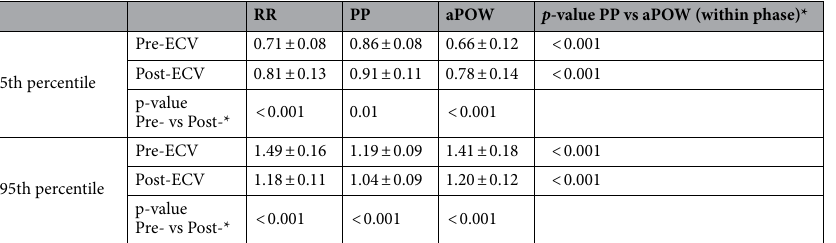
Table 3. Phase-specific (pre- and post-ECV) Rp values for RR interval, PP and aPOW. *p-values are derived by Kolmogorov–Smirnov test.